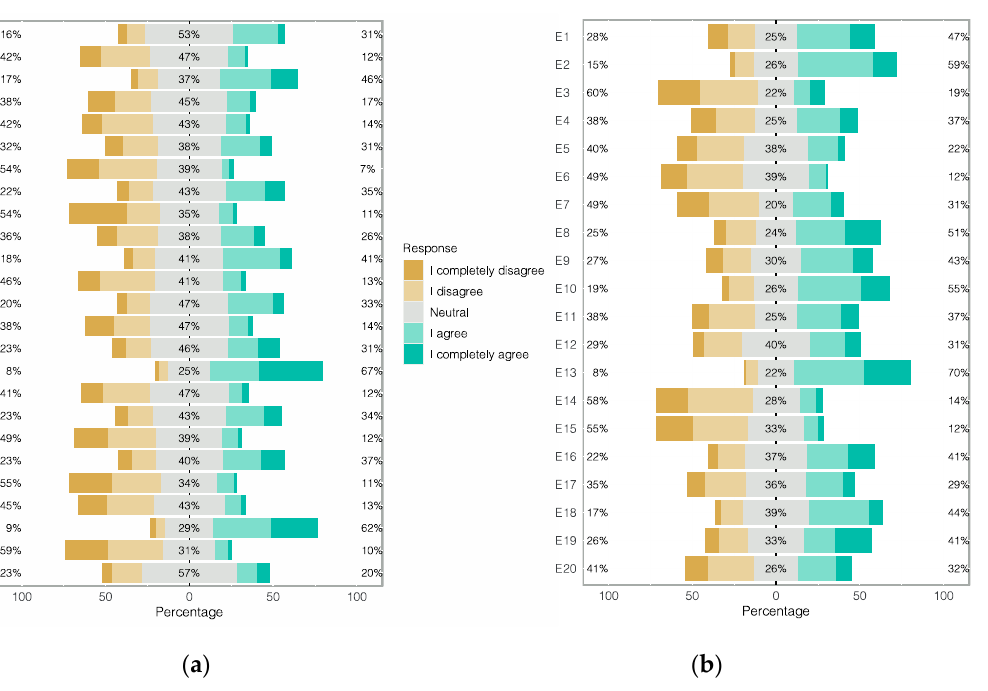
Figure 1. Distribution of students’ responses. ( a ) MSATS and ( b )